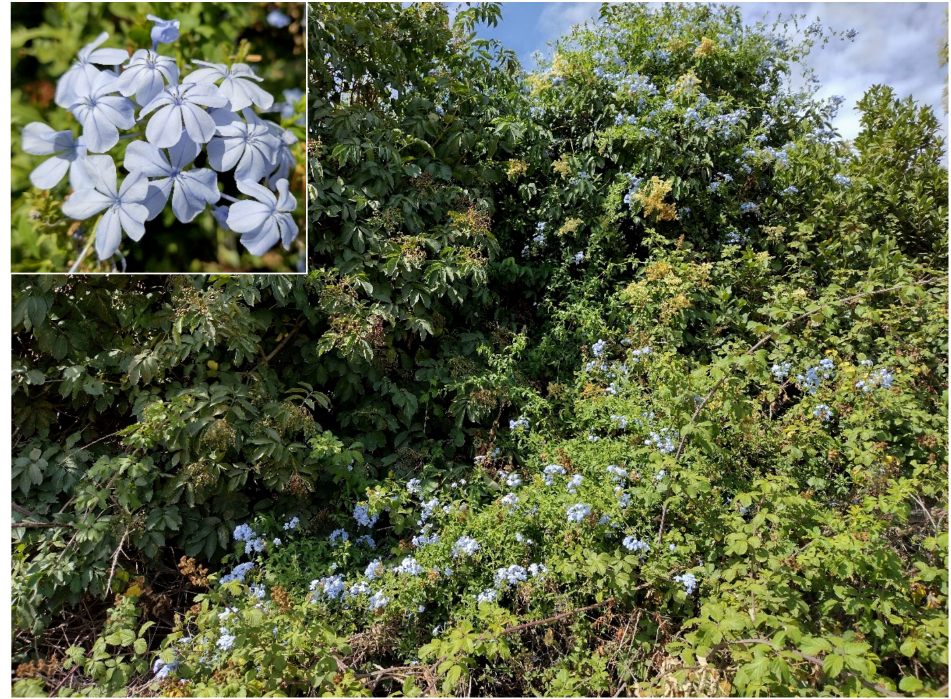
Figure 80. Plumbago auriculata in shrubby vegetation (Caffarella